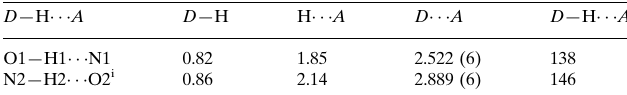
Hydrogen-bond geometry (A˚ , (cid:1)